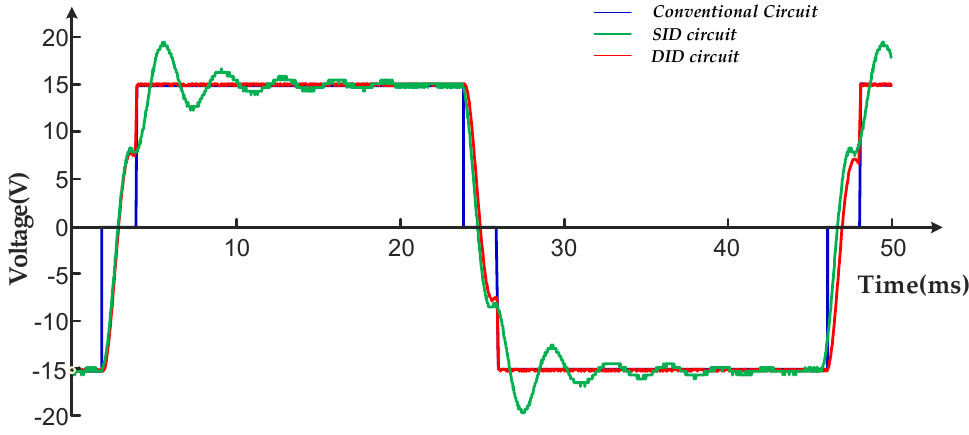
Figure 13. Voltages of PZT driven by three circuits.